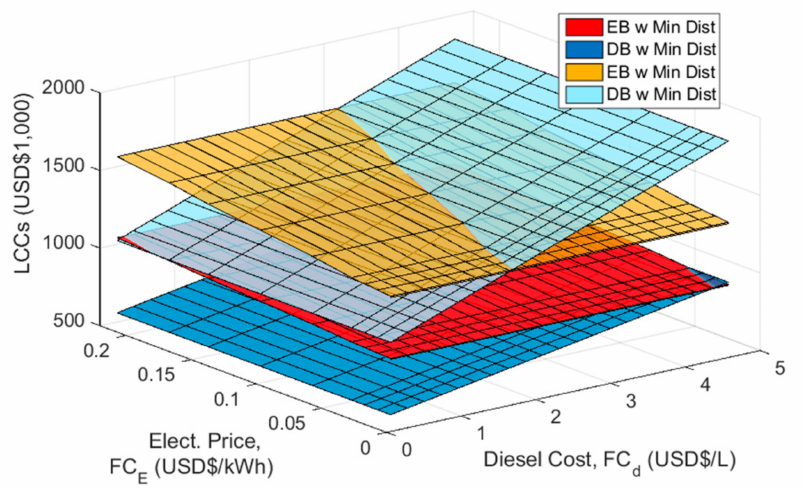
Figure 9. LCCs of electric and diesel buses, against diesel cost and electric